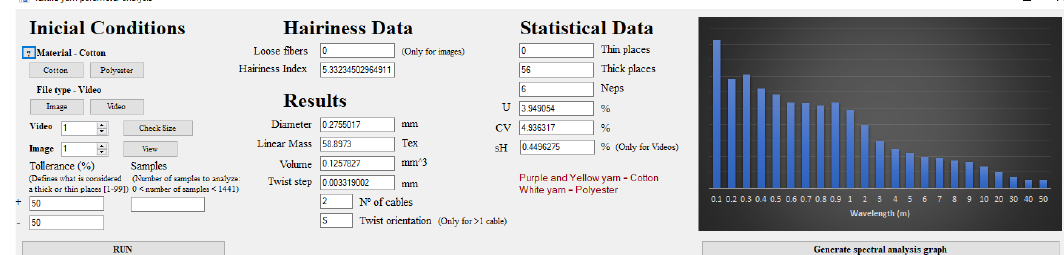
Figure 40. Presentation of spectral analysis results of purple cotton yarn in the user interface.